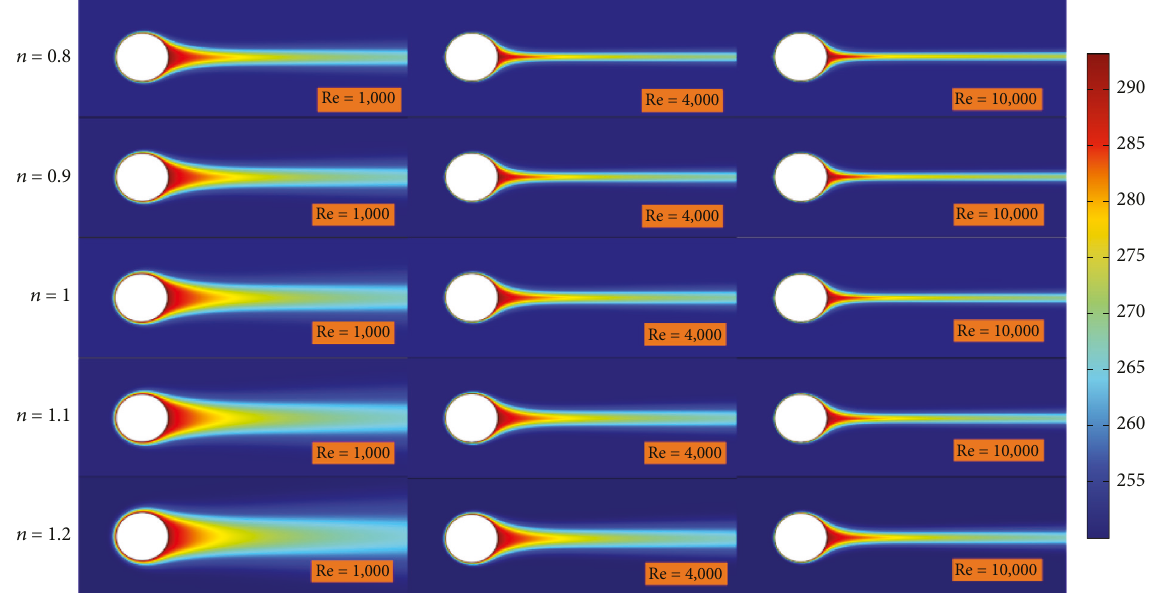
Figure 11: Contours of temperature for r � 0 . 2.